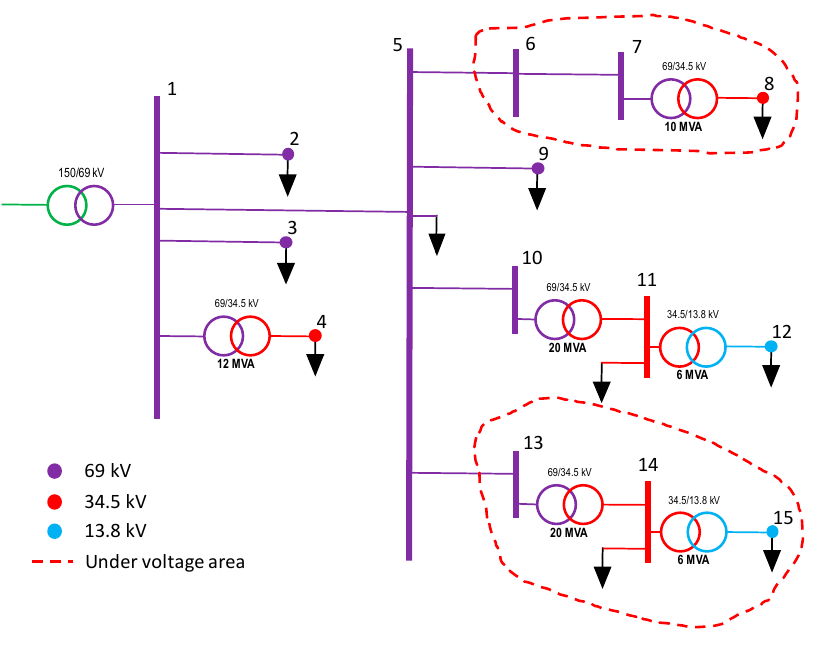
Figure 6. Case study: undervoltage areas.